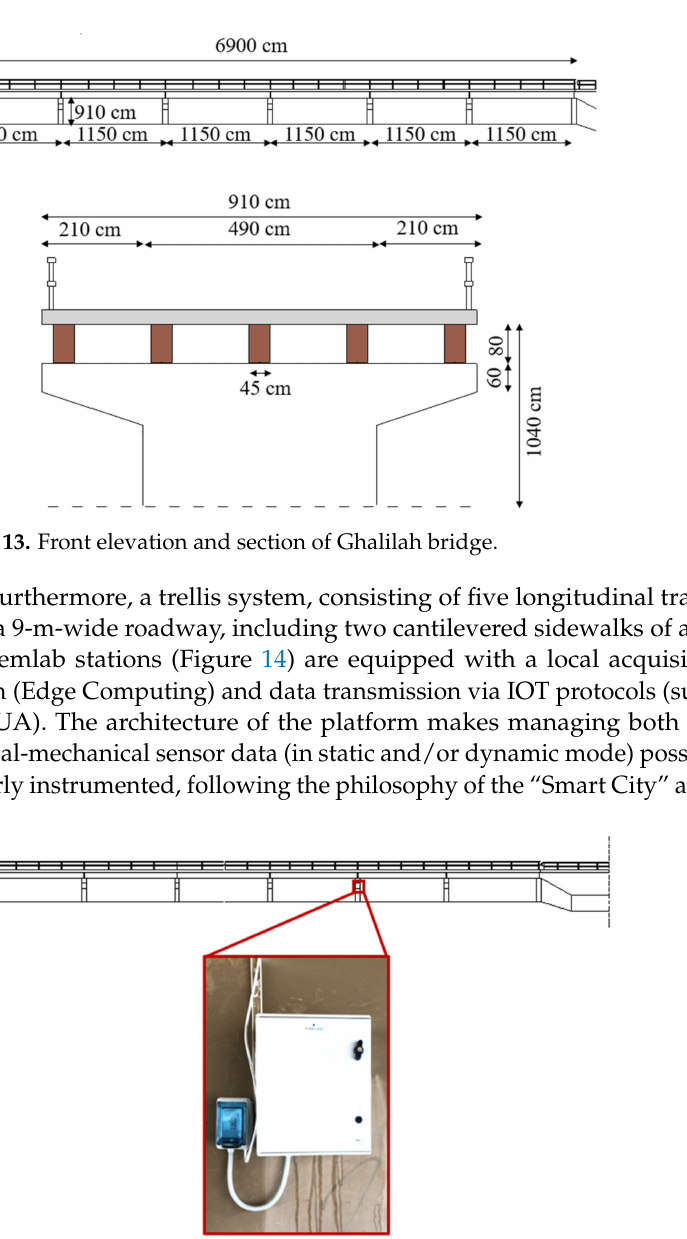
Figure 14. TEM monitoring station positioned in the Ghalilah